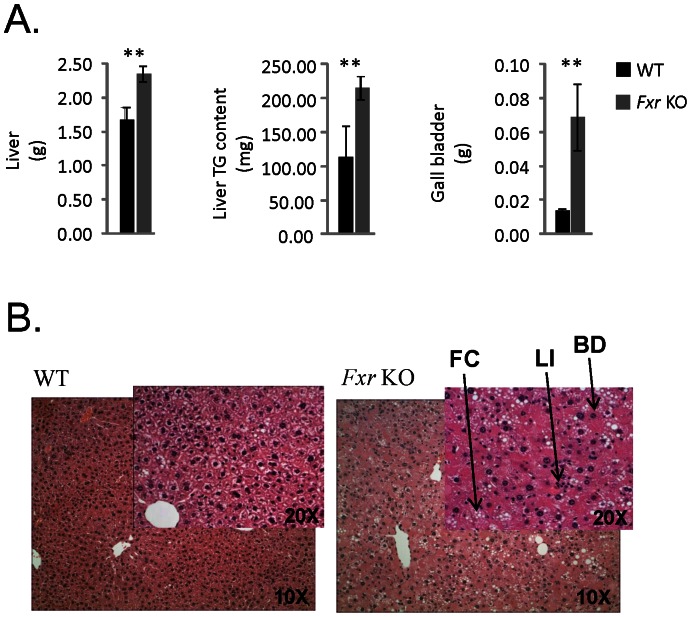
Tissue weight and triglyceride content.(A) Weight of liver, liver triglyceride (TG) content and weight of the gall bladder in WT (n = 8, black bars) and Fxr KO mice (n = 8, grey bars). Statistical analysis was performed using Student's T-test. ** p<0.01 Fxr KO vs. WT mice. (B) Representative slides of livers from WT (n = 8) and Fxr KO mice (n = 8) as indicated. The arrows indicate perisinusoidal/sinusoidal foam cells (FC), lobular inflammation (LI) and ballooning degeneration (BD).